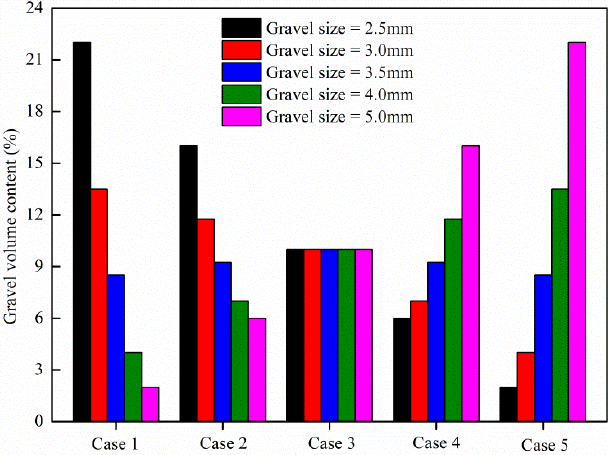
Figure 22. Numerical cases of five models with different gravel size gradations.